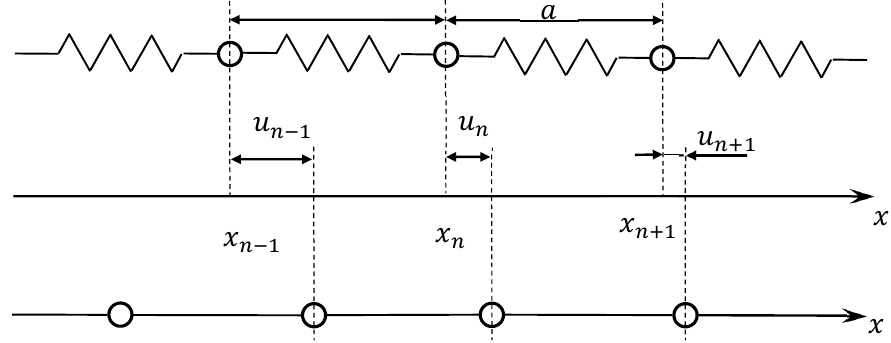
Figure 18. The propagation of a longitudinal disturbance in a chain of atoms.